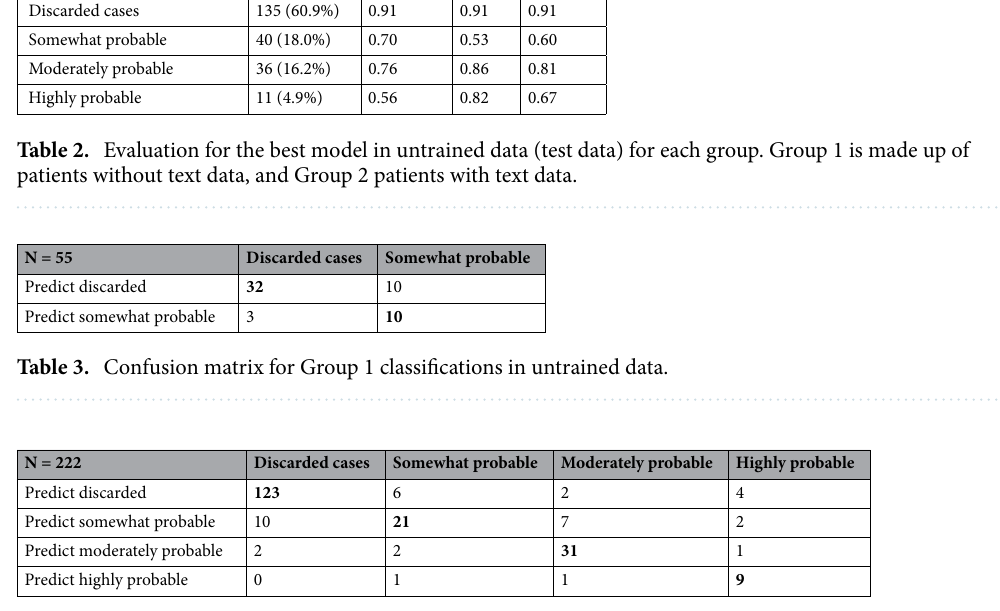
Table 4. Confusion matrix for Group 2 classifications in untrained